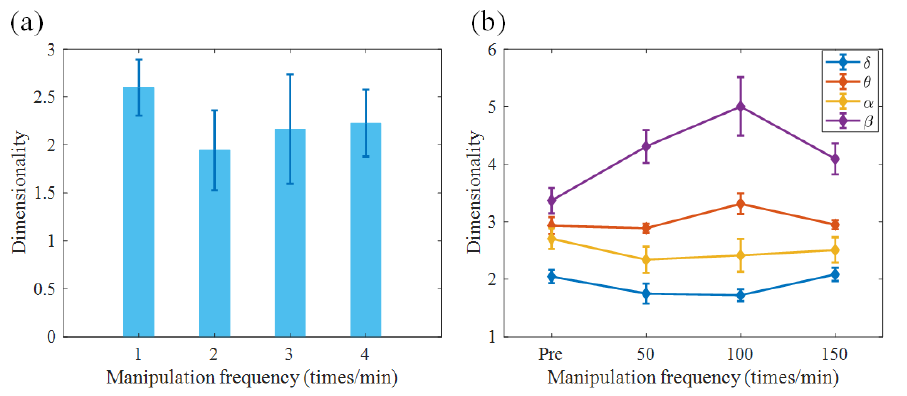
Figure 4. Dimensionality of brain activity. ( a ) Dependence of dimensionality of brain activity on acupuncture manipulation. ( b ) Dependence of dimensionality of brain activity in different sub-bands on acupuncture manipulation. Acupuncture can reduce the dimensionality of brain activity, especially with the manipulation at 50 times/min. The dimensionality in the delta and alpha frequency band was lower than that in the other two bands.